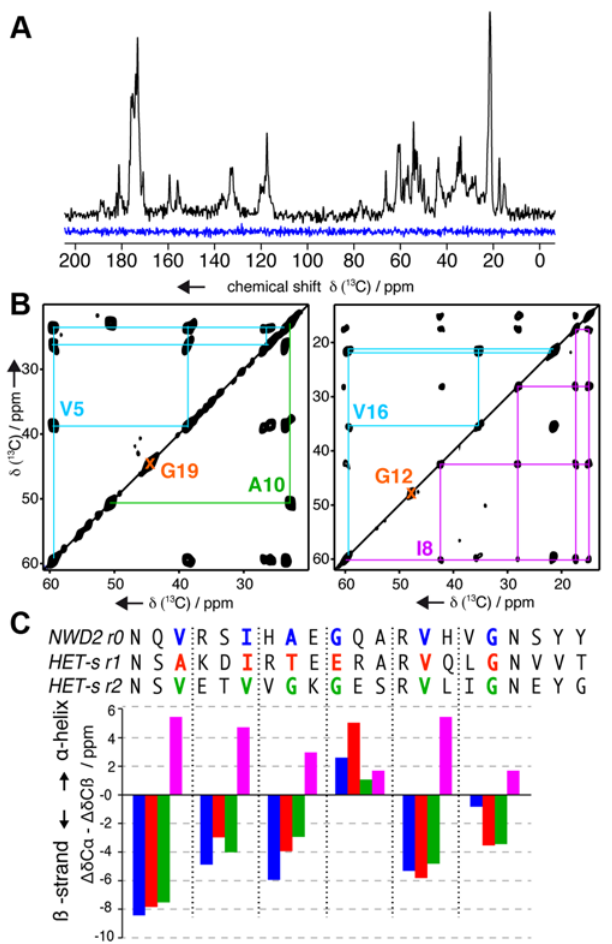
Fig 8. Conformational analysis of NWD2 fibrils by solid-state NMR. A. Solid-state NMR 13C spectra on natural abundance NWD2(3 – 23), recorded using a cross-polarization (black) and INEPT (blue) polarization transfers. B. Two-dimensional solid-state NMR 13C-13C correlation spectra of NWD2(3 – 23) fibrils, isotopically 13C labeled on Val5, Ala10, Gly19 (left) and Ile8, Gly12, Val16 (right). 13C resonance assignment of each amino acid is illustrated by lines: blue for Val, orange for Gly, green for Ala and pink for Ile. C. Comparison of the secondary structure encoded in the secondary chemical shift of NWD2 r0 (13C labeled residues in blue) with HET-s r1 (red) and r2 (green). Negative or positive values indicate β -strand or α -helix conformation respectively. Illustrated in pink are the hypothetical secondary chemical shifts for each residue of NWD2 in α -helical conformation